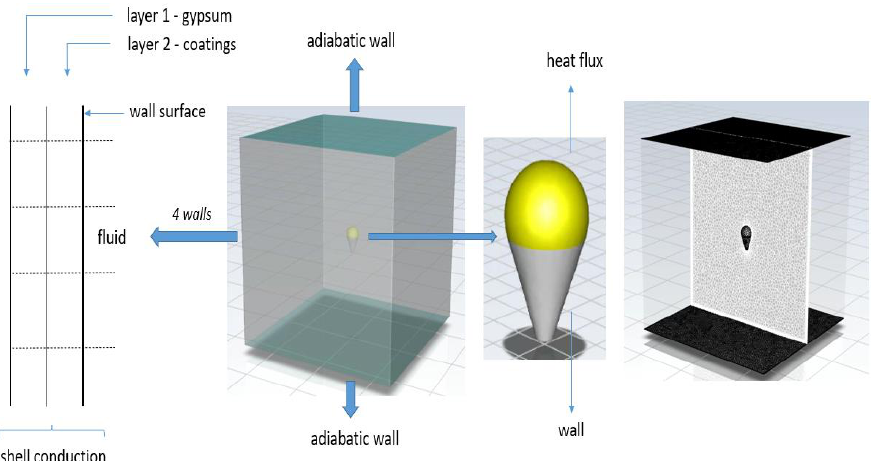
Figure 5. Numerical model of test bench.